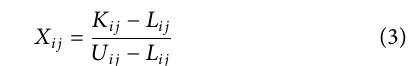
Frontiers in Energy Research |